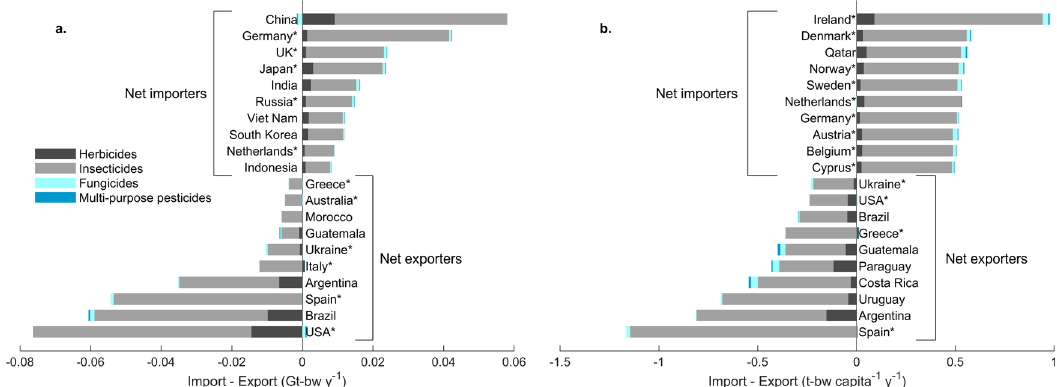
Fig. 3 Pesticide footprints embodied in the international trade for the top-ten net importing and exporting countries. a Total net imports and exports. b per-capita net imports and exports. Net importers are exerting more environmental pressures abroad as a result of their consumption of imported products and services than locally due to their exports, and vice versa for net exporters. Analysis was conducted based on primary producer to fi nal consumer perspective. *Developed and economies in transition countries. Broad regions are not included in this plot but are represented in Supplementary Fig. 8.